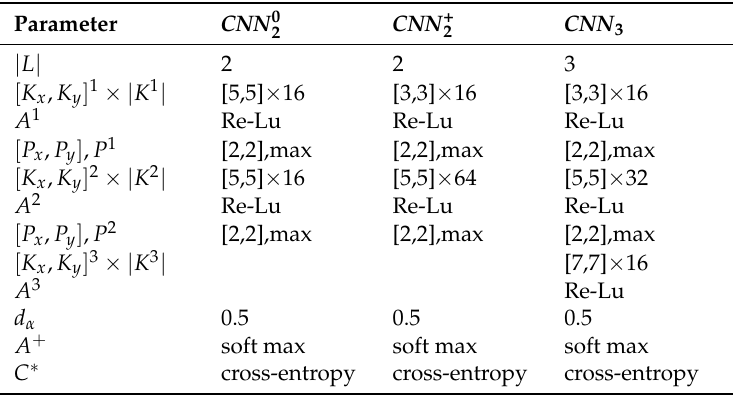
Table 1. Configurations of Convolutional Neural